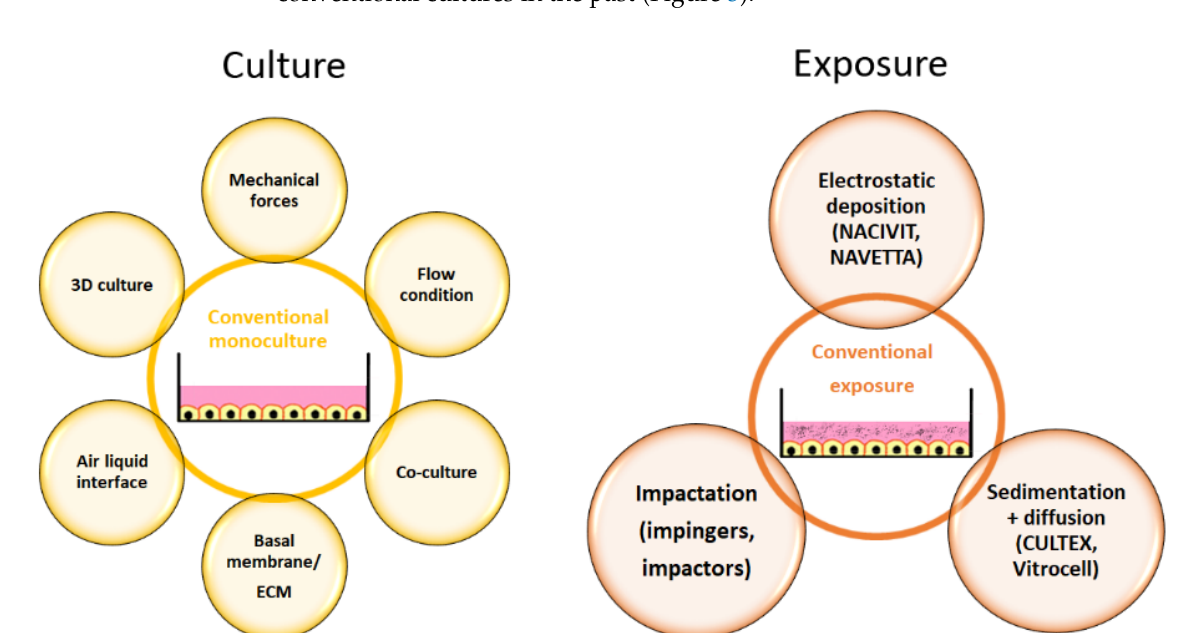
Figure 3. Adaptations in cell culture (yellow) and exposure (brown) that result in physiologically more relevant in vitro models. Abbreviation: ECM, extracellular matrix